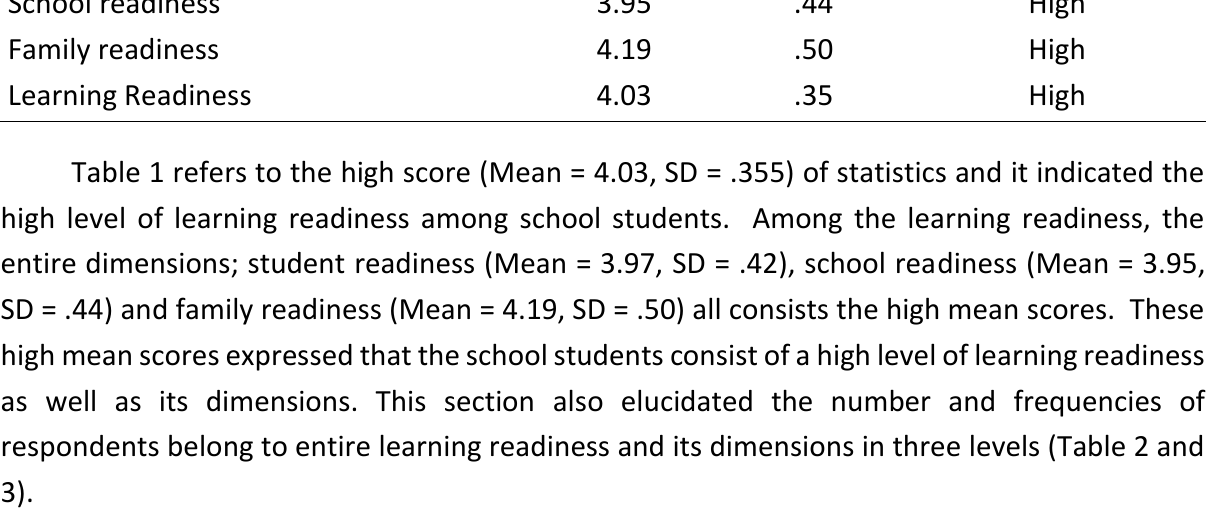
Table 2: Frequencies of Learning Readiness among School Students Dimensions of Learning